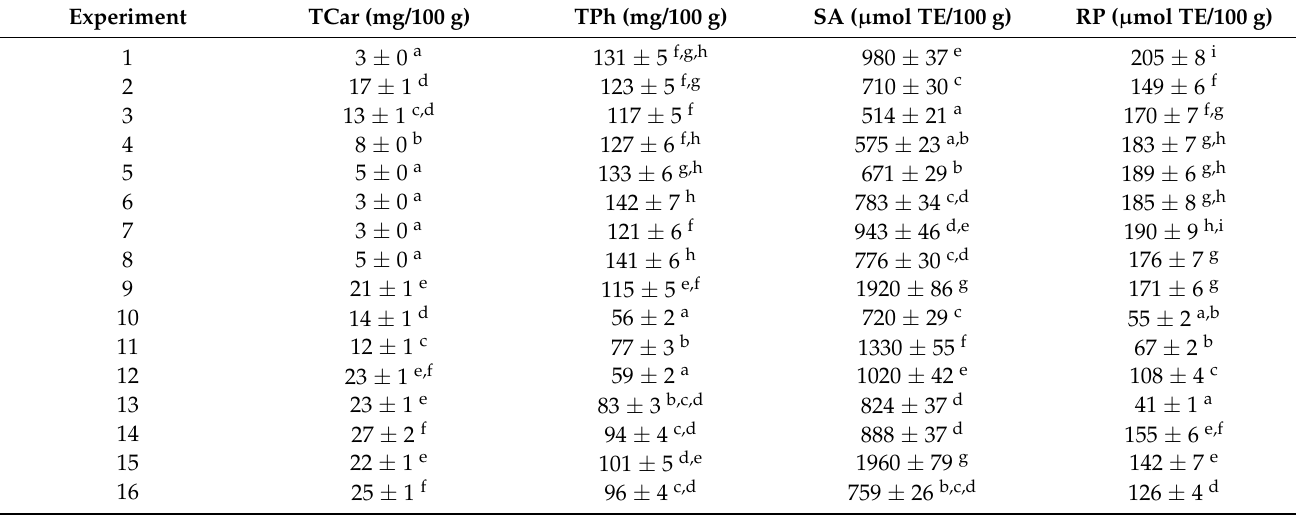
Table 2. Total carotenoid (TCar) and polyphenol (TPh) contents in carrot extracts and their scavenging activity (SA) and reducing power